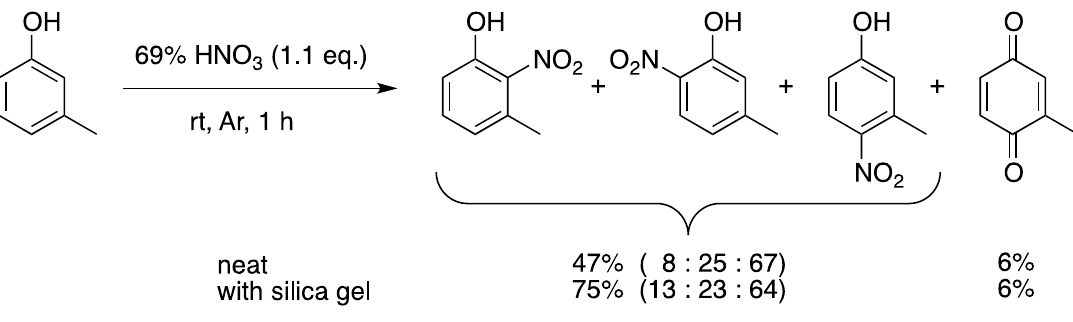
Table 3. Some reported examples of the nitration of m -cresol under various conditions. Conditions Yield (%)